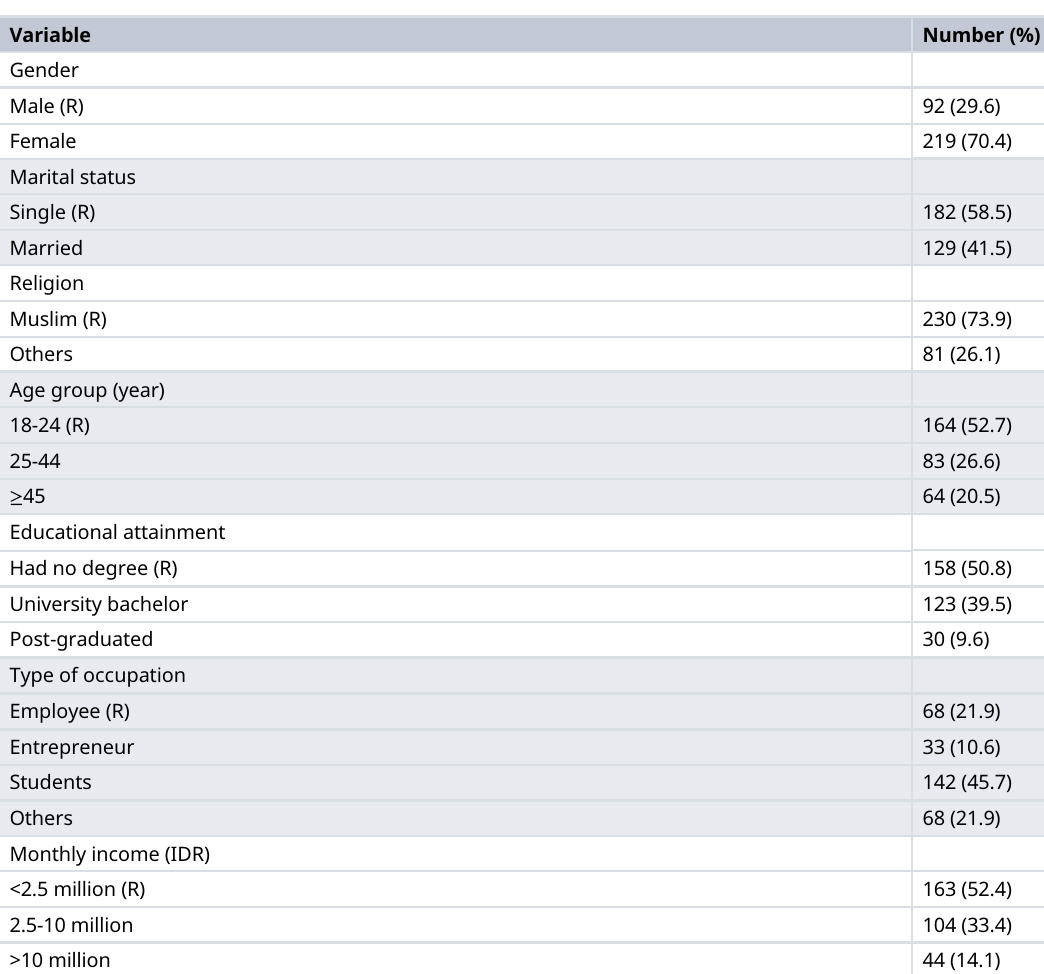
Table 2. Demographic characteristics of respondents (n =